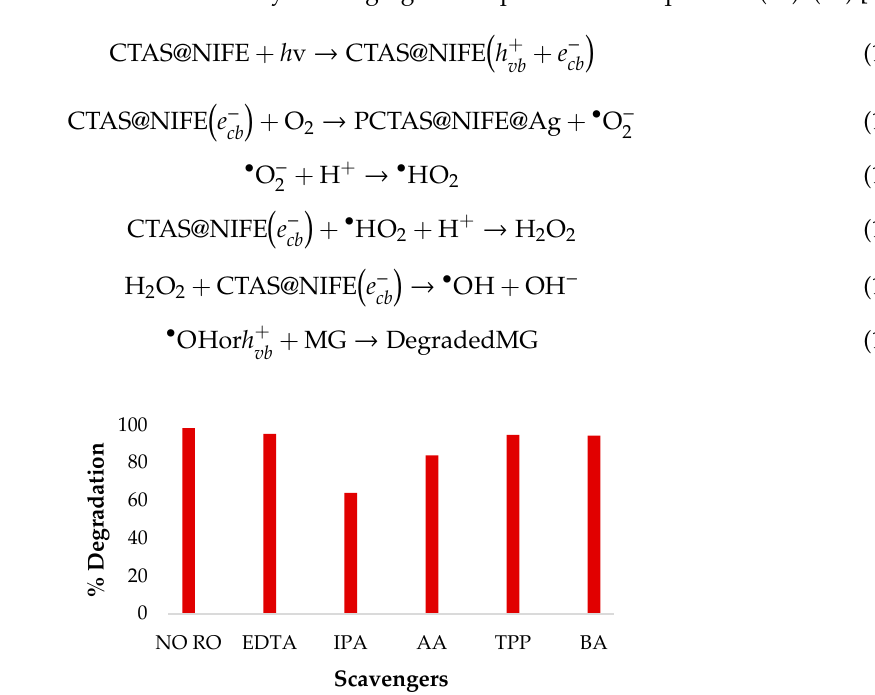
Figure 11. Examination of the effect of various scavengers to observe the type of reactive oxidant (RO) involved in photocatalytic degradation using 20 mg catalyst with 20 mL of 70 mg·L –1 MG and 3 mM solution of each scavenger at pH 8, 90 min irradiation time, and 6.35 W·mL –1 ultrasonic power.